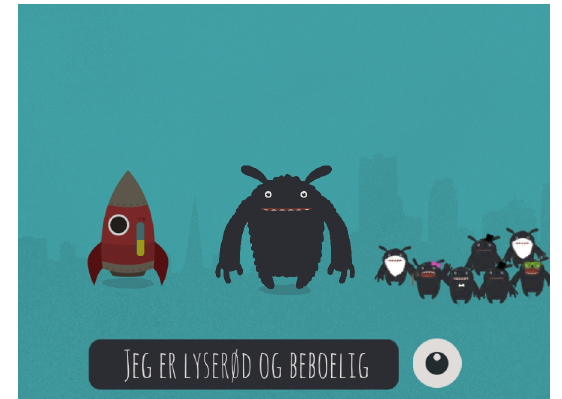
Figure 3. Riddle-based navigation showing the monster character withpointsin the formof fuels and friends.